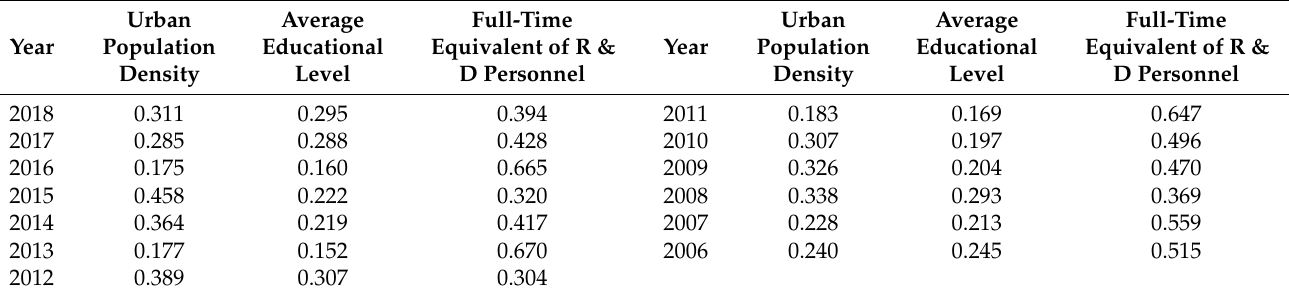
Table A1. Weight of human capital dimension.